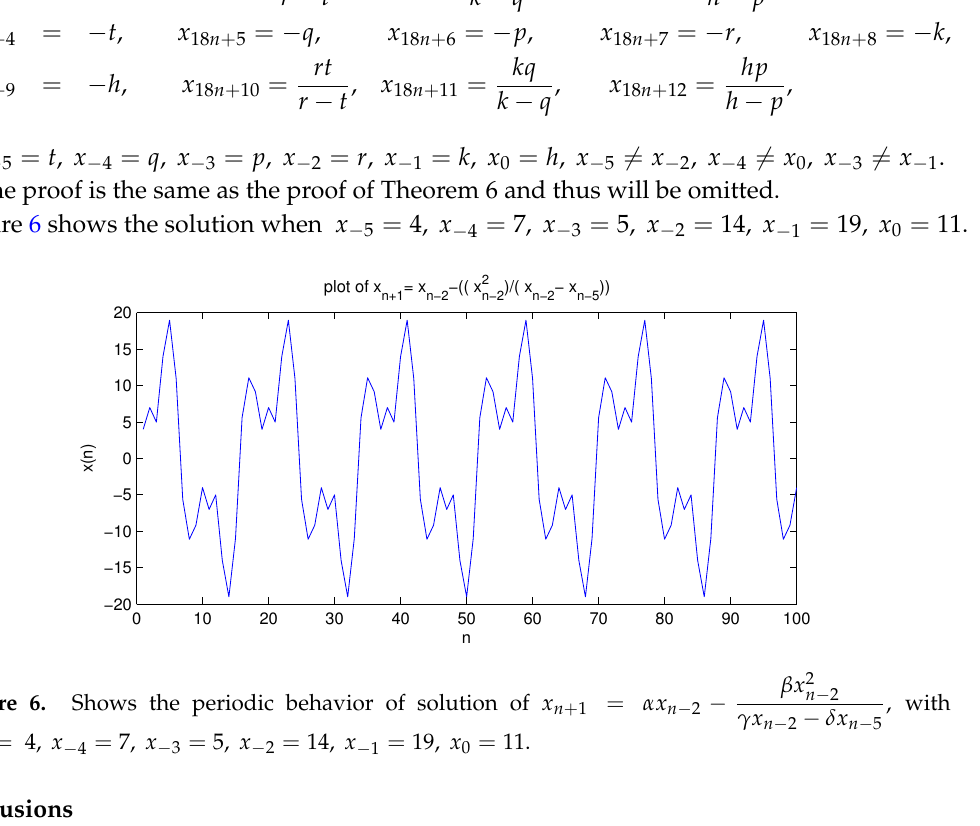
β x 2 n − 2 , with γ x n − 2 − δ x n − 5